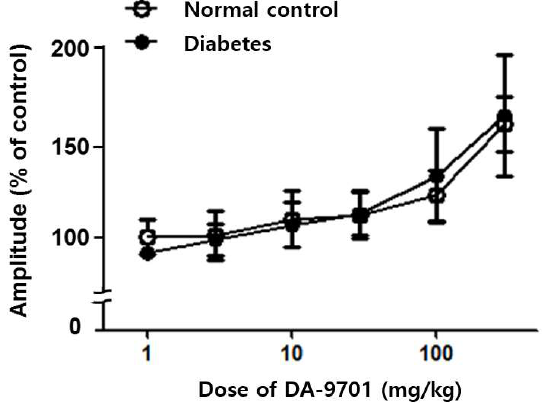
Figure 7. Effect of DA-9701 on small intestinal motility in normal control and streptozotocin-induced diabetic mice. In both the normal control and diabetic groups, DA-9701 increased the spontaneous movement of the small intestinal muscle in a dose-dependent manner, without significant difference between two groups. (n = 10 in each group). Baseline colonic motility showed no definite difference between the diabetic and nor- mal control groups. Despite the similar initial contractility between the two groups, co- lonic motility was dramatically improved after DA-9701 treatment in the diabetic group in a dose-dependent manner. In the control group, colonic motility did not respond to treatment with 30 mg/kg of DA-9701 and improved at over 30 mg/kg of DA-9701. How- ever, the improvement was less than that in the diabetic group (Figure 8).